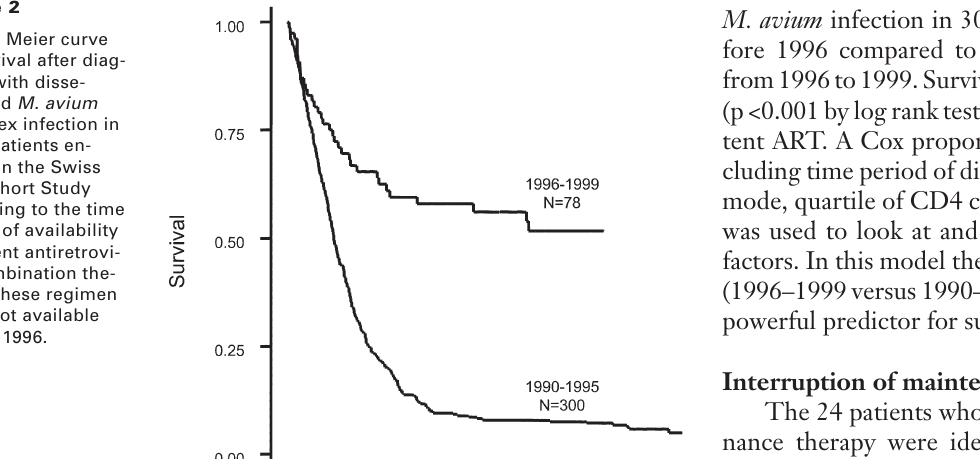
Kaplan Meier curve of survival after diag- nosis with disse- minated M. avium Complex infection in AIDS patients en- rolled in the Swiss HIV Cohort Study according to the time period of availability of potent antiretrovi- ral combination the- rapy. These regimen were not available before